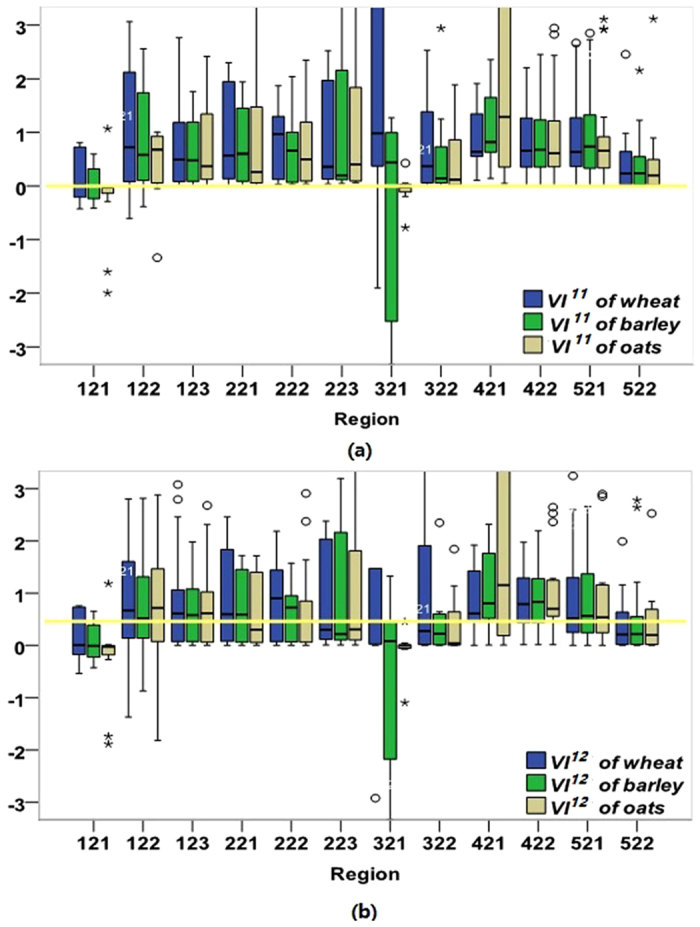
Box plots of the optimal vulnerability (e.g., VI11 and VI12) for wheat, barley, oats, and their resilient and sensitive regions.The numbers under the horizontal axis present region codes.